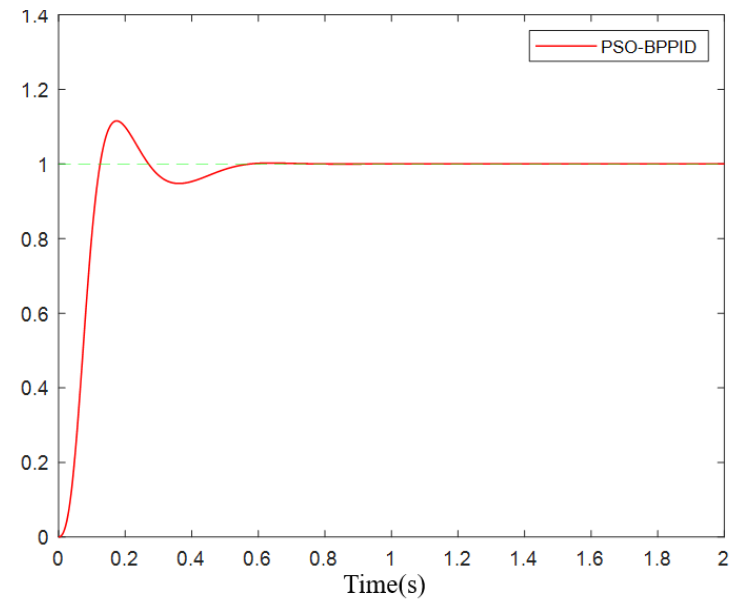
Figure 11. Time domain simulation curve of the PSO-BP-PID controller step response.